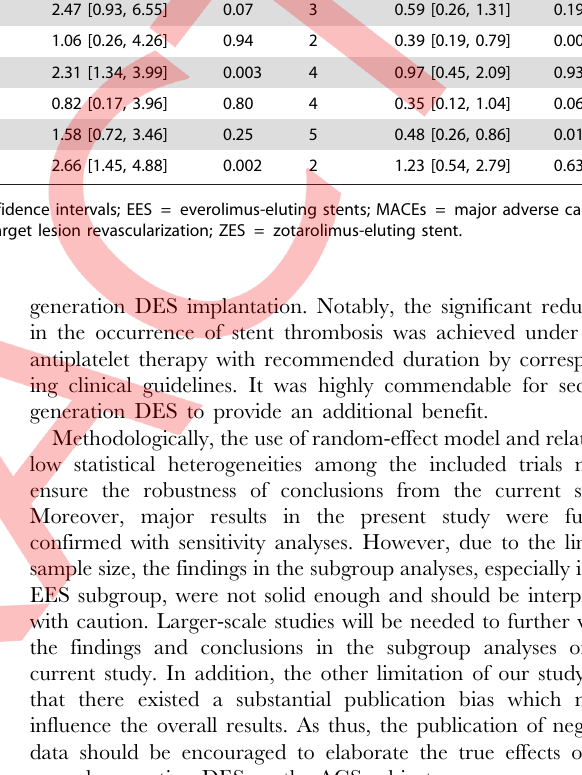
MACEs TLR Stent thrombosis